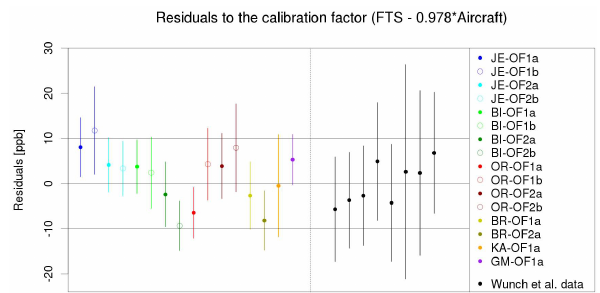
Fig. 7. Residuals (cDMF FTS − ψ I + W cDMF aircraft ) calculated for all calibration points using aircraft profiles as a-priori for the GFIT retrieval. The error bars are the squared sum of the FTS and the aircraft